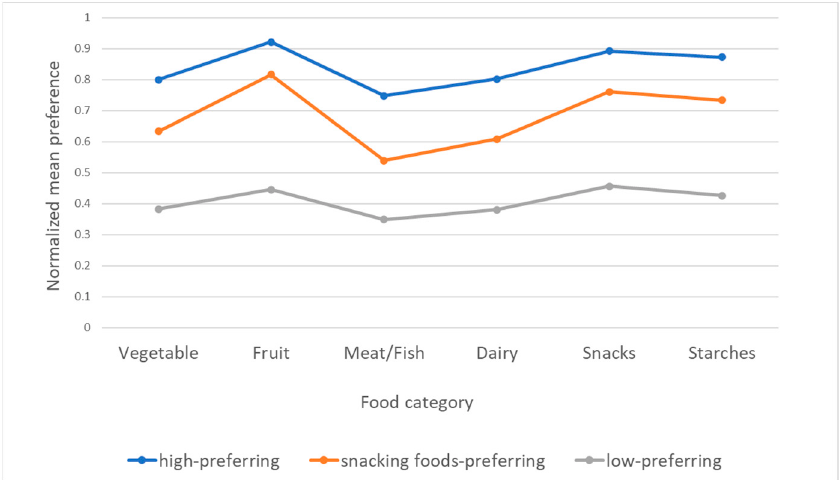
Figure 1. Normalized mean values for the preference within the sub-groups stratified based on the clustering of the preferences assessed by Food Preference Questionnaire (FPQ) within the population of the second phase of the Polish Adolescents’ COVID-19 Experience (PLACE-19) Study ( n = 2419).